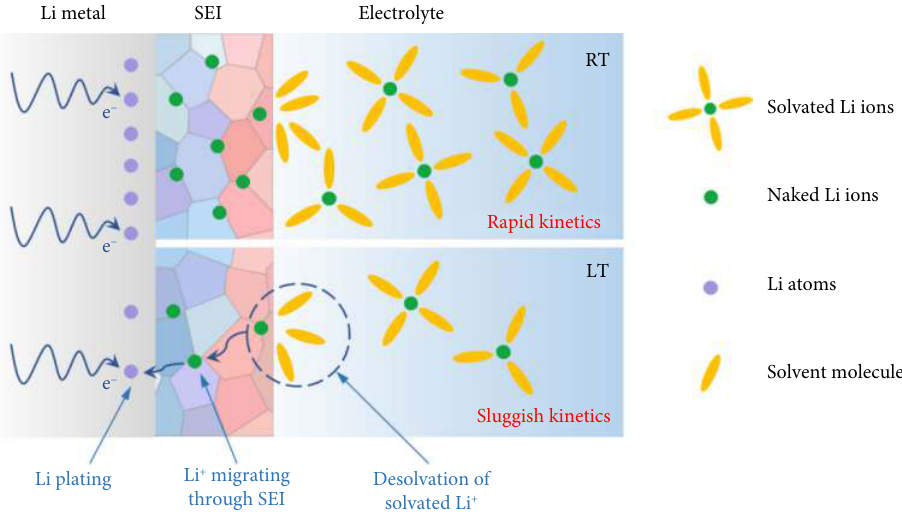
Fig. 2 Schematic diagram illustrating the diffusion process of Li ions from cathode to anode surface followed by reacting with electrons and transforming into Li metal.